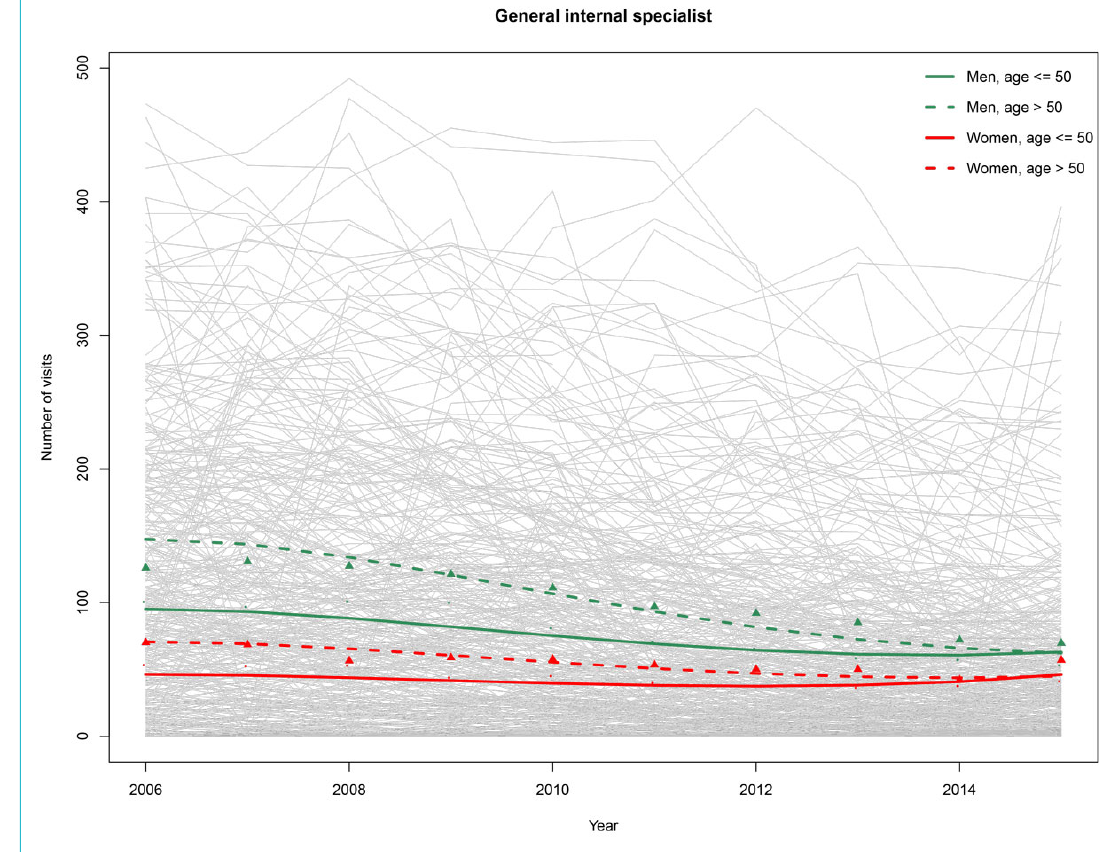
Figure 1: Evolution of home visits made by general internists in the canton of Vaud between 2006 and 2015, by gender and baseline age. Grey solid lines: spaghetti plot of annual number of visits per physician; 1 line = 1 physician. Dots: observed average number of home visits per year per physician, physicians up to 50 years old, green = men, red = women. Triangles: observed average number of home visits per year per physician, physicians older than 50 years, green = men, red = women. Green and red lines: predicted values of average number of home visits from the regression model, green = men, red = women, solid line = physicians up to 50 years old, dashed line = physicians older than 50